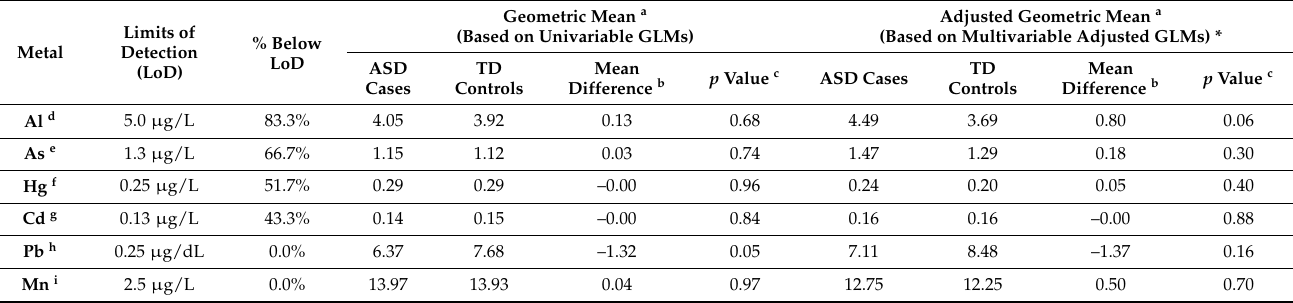
Table 3. Geometric mean of blood metal concentrations based on univariable and multivariable General Linear Models (GLMs) that account for four possible confounders and potential clustering effects of the matched pairs of ASD cases and TD controls (30 matched pairs or 60